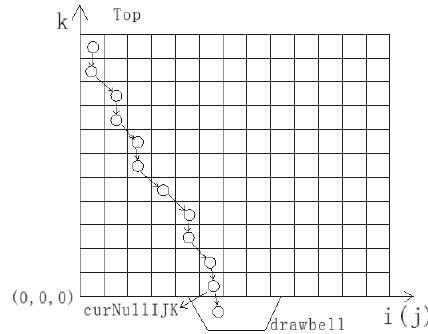
Figure 3. Particle flow model.